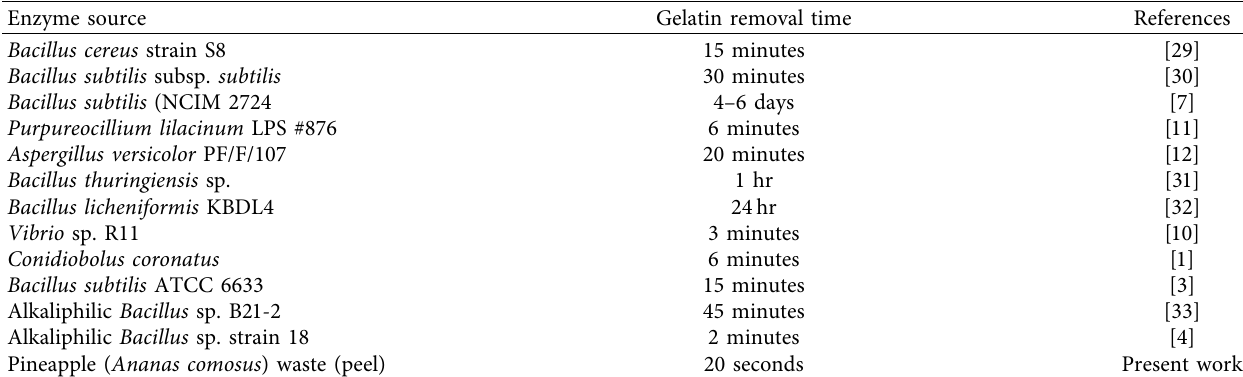
Figure 1: (a) Pineapple juice processing waste (peels). (b) Crude extract of bromelain Table 1: Gelatin removal efficiency of enzymes obtained from different organisms.